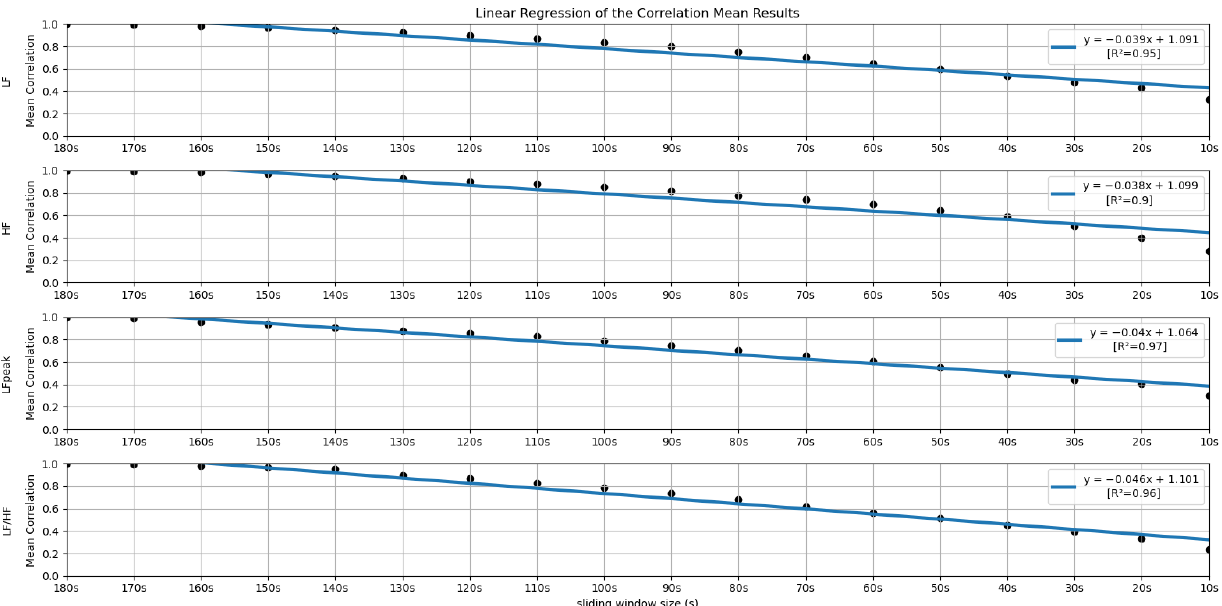
Figure 13. Linear Regressions of the Mean Correlations across runs obtained for the features LF, HF, LFpeak and LF/HF.